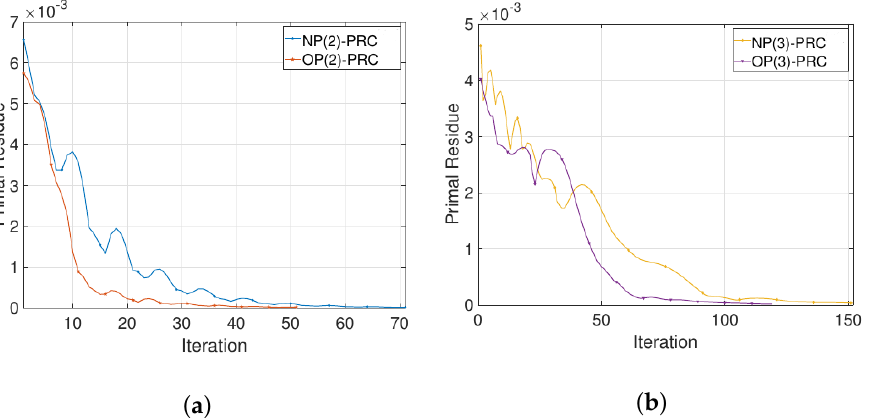
Figure 5. Convergence of primal residual with different partitions. ( a ) Two regions, convergence performance; ( b ) Three regions, convergence performance. (NP(2)-PRC and NP(3)-PRC are from